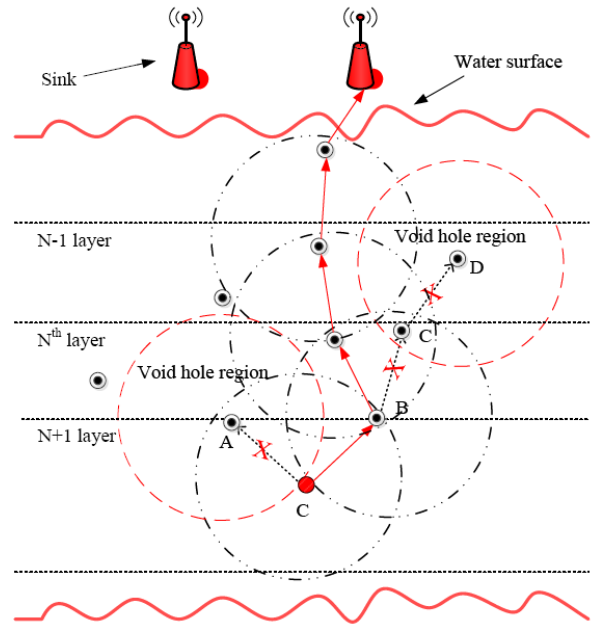
Figure 15. Information sharing strategy between one and multi-hop neighbors.